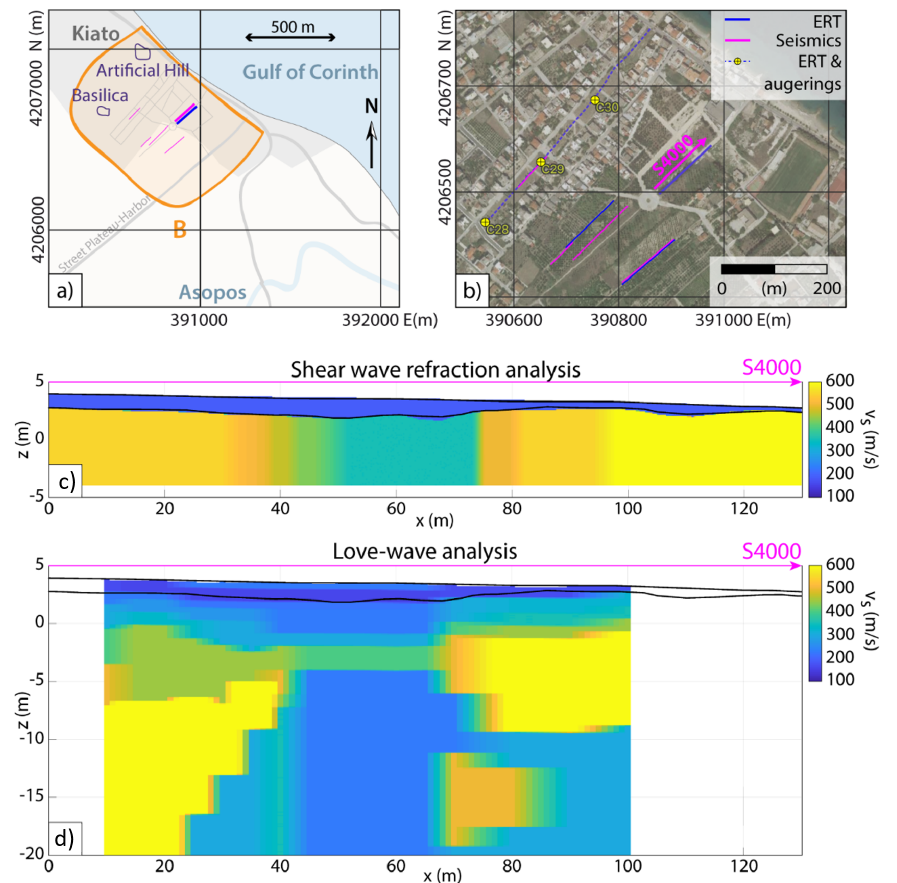
Figure 10. ( a ) Case 6: Silted-up harbor of Old Sikyon. ( a ) Sketch of survey area B (compare Figure 1c). ( b ) Location of the electrical resistivity tomography (ERT) and seismic profiles in the harbor area Source of satellite image: Google Earth. ( c ) Results of the refraction analysis of seismic line 4000. ( d ) Results of the love wave analysis of seismic line